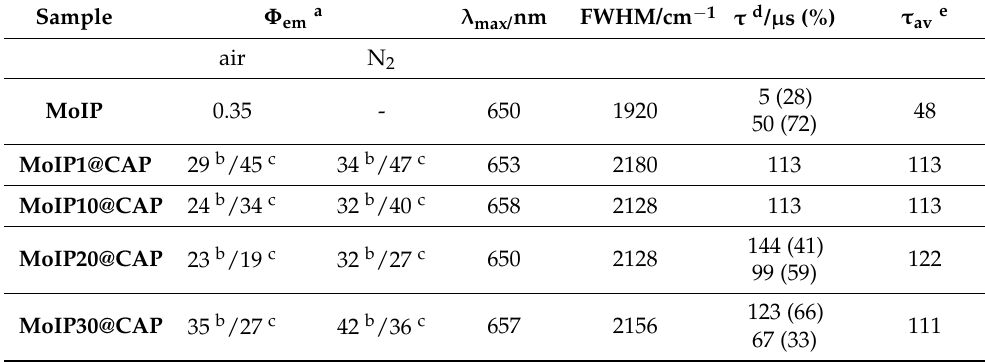
Table 2. Emission properties of the cluster complex and the doped CAP